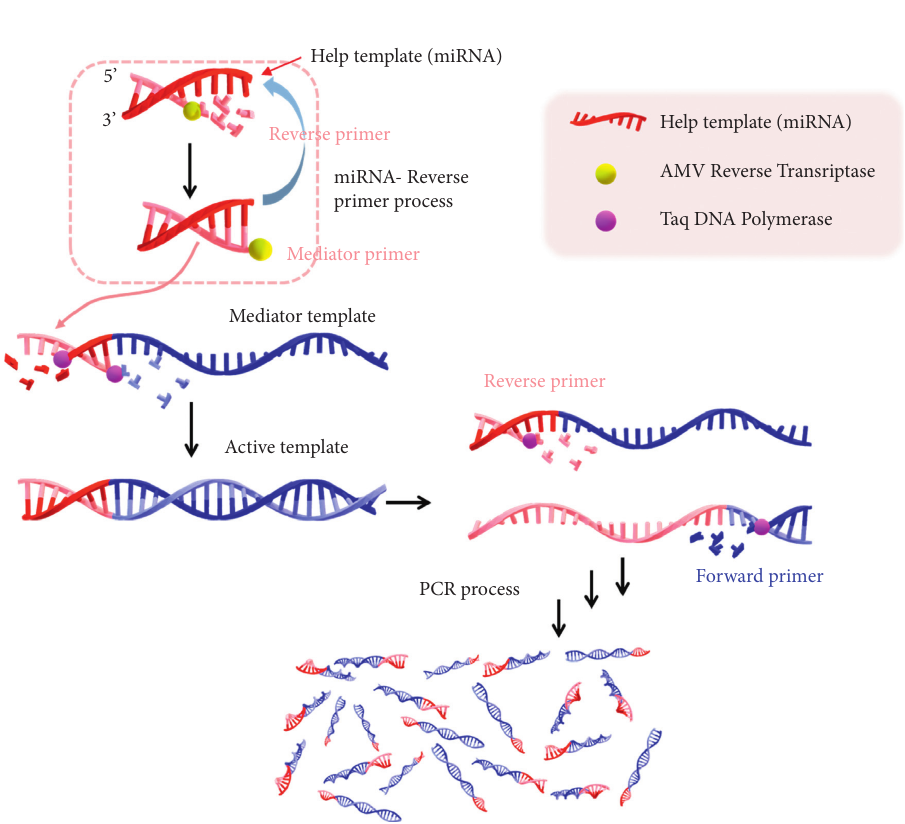
SCHEME 1: Schematic representation of helper qPCR method for miRNA